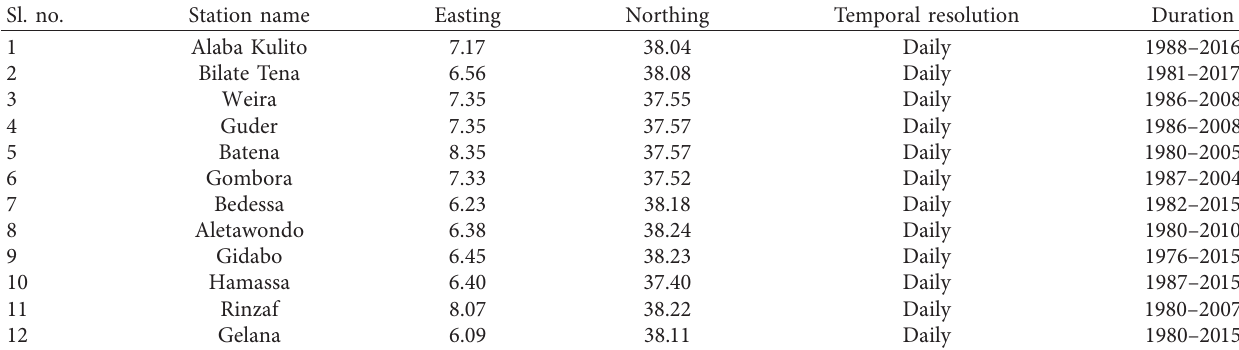
Table 2: Available hydrological stations within and round the Bilate basin. Sl. no.